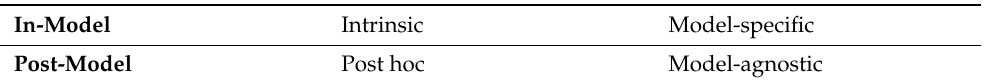
Table A1. Association between XAI Interpretability Criteria where In-model and Post-model inter- pretability are defined using XAI